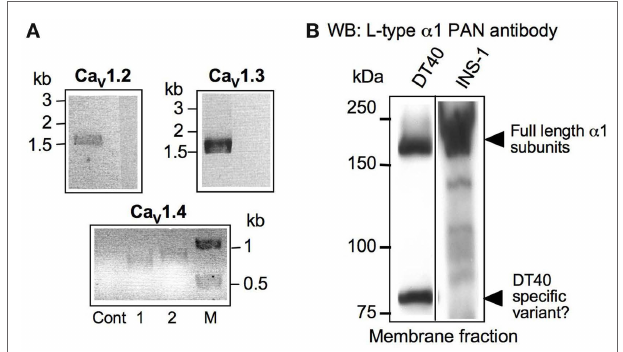
FiGUre 2 | Gene and protein expression of Ca V 1 α 1 family members in dt40 B-cells. (a) RT-PCR using primer combinations specific for the indicated chicken version of Ca V 1.2 (1.5 kb,), 1.3 (1.6 kb), and 1.4 (656 and 761 bp, lanes 1 and 2, respectively). M = marker. All PCR-fragments have been cloned and sequenced for verification. The negative control lanes (Cont) are reactions containing RNA as template. (B) Western blot from DT40 membrane fraction lysates developed using L-type α 1 PAN antibody. As a positive control, the excitable pancreatic rat beta cell line INS-1 was